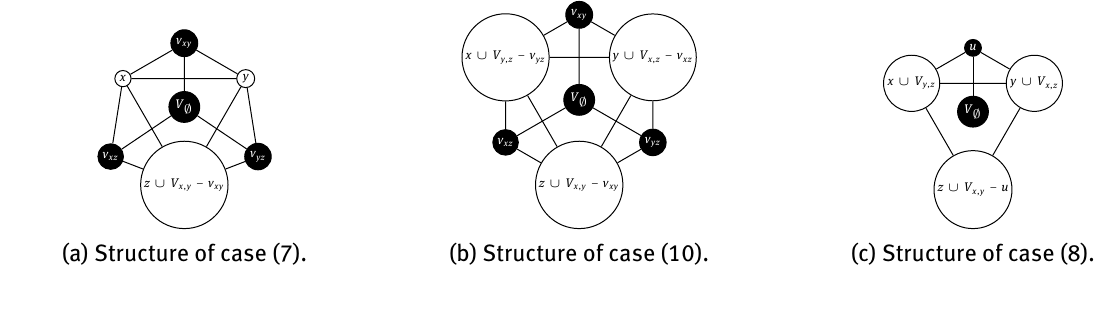
Figure 7: Graphical description of cases (7), (8) and